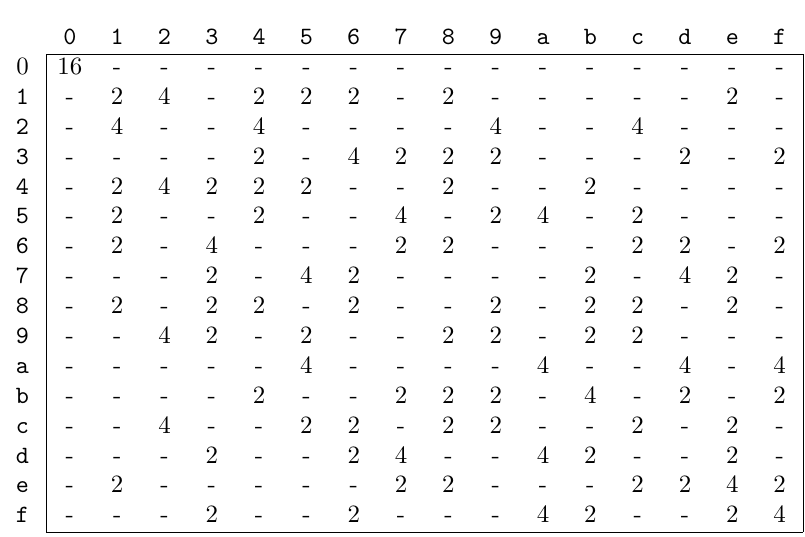
Table 12: DDT of CRAFT ’s 4-bit S-box